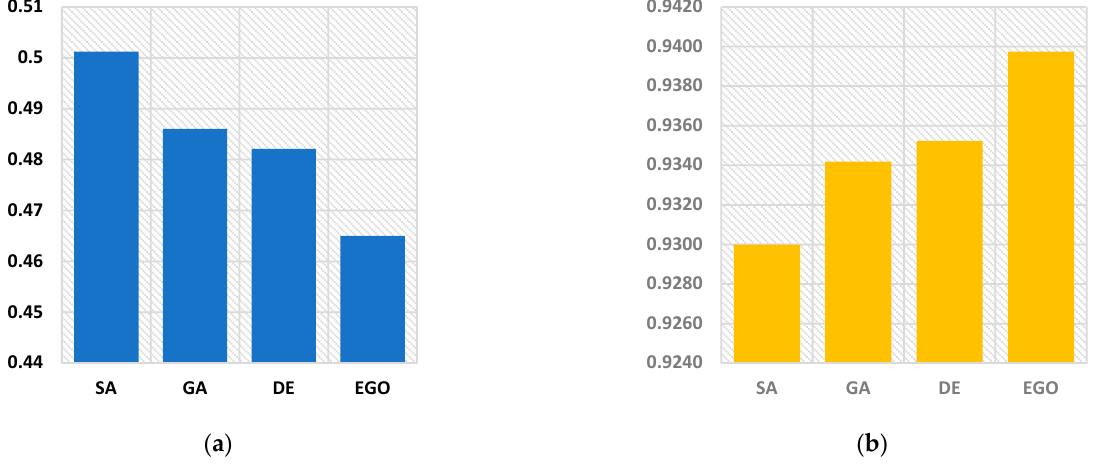
Figure 13. RMSE ( a ) and R 2 values ( b ) for parameter estimation using yearly data (own elaboration). According to the Small Wind Guidebook provided by the U.S. Department of Energy, Office of Energy Efficiency and Renewable Energy, Skystream 3.7 is a type of wind turbine that can be used in urban areas [89]. The Skystream 3.7 is a wind turbine that turns wind into usable electricity for homes and small businesses. For households and smaller busi- nesses, Skystream 3.7 may supply 40% or up to 90% of their total energy needs [88]. Taking Skystream 3.7 installed in Gda ń sk city center.